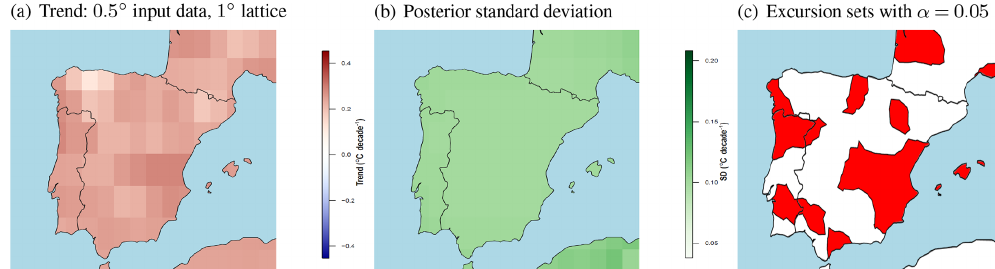
Figure 3. Trend estimates for the Iberian Peninsula based on input data on a 0.5 ◦ grid. (a) Posterior mean estimates of the trend coefficient (in ◦ Cdecade − 1 ) projected on a regular 1 ◦ lattice. (b) Posterior standard deviation of the trend coefficient on the same lattice. (c) Avoidance excursion set where the spatial null hypothesis of no trend is rejected for the level α = 0 . 05 (red). Note that the estimates outside Iberia are based on data